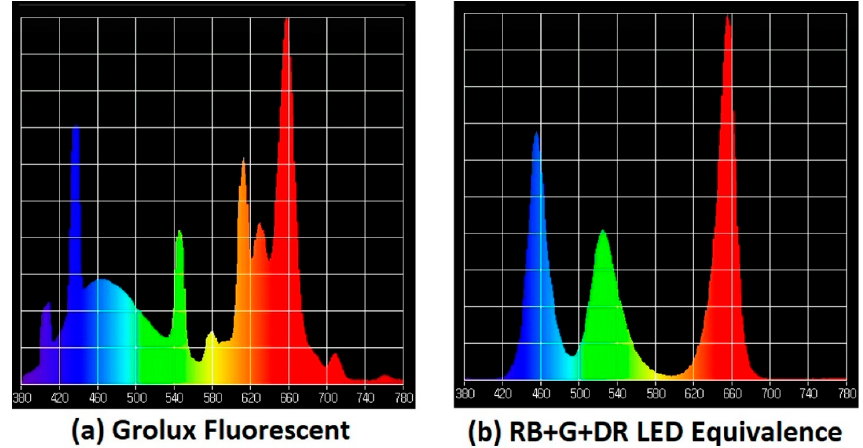
Figure 3. Comparison of the light spectra of ( a ) Grolux fluorescent and ( b ) R + G + B LED equiva-